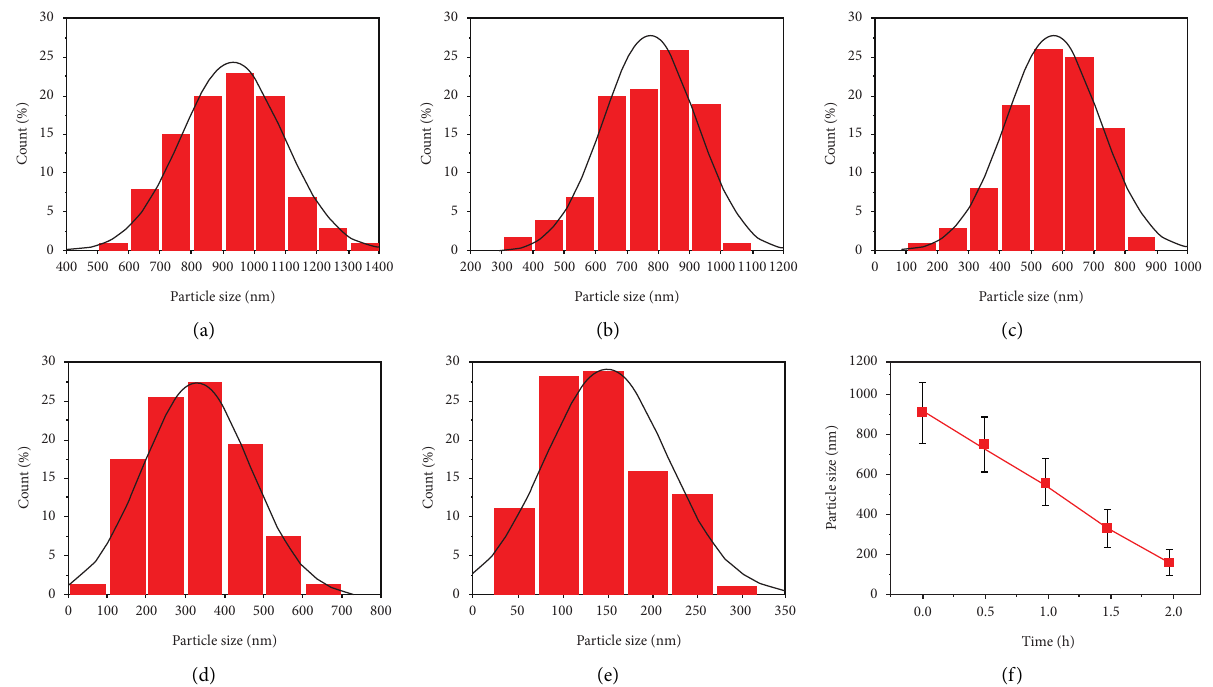
Figure 3: Particle size histograms of (a) Unmilled (0 h), (b) Milled @ 0.5 h, (c) Milled @ 1 h, (d) Milled @ 1.5 h, (e) Milled @ 2 h, (f) Evolution of the zinc oxide NPs’ average size versus the milling time.